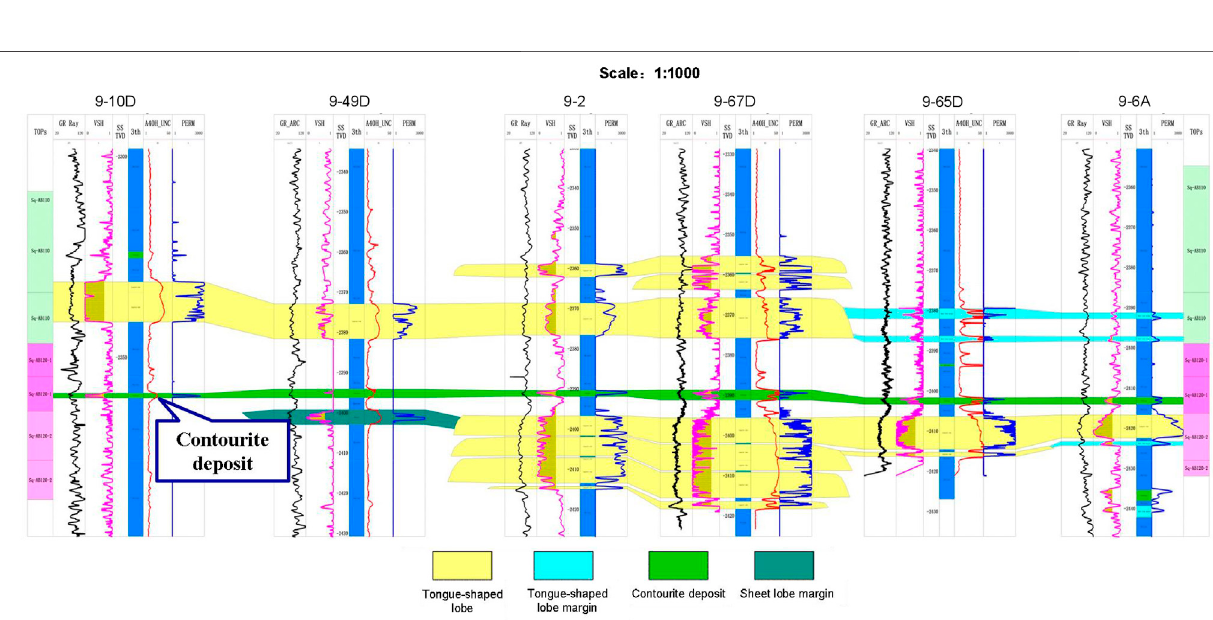
Frontiers in Earth Science |